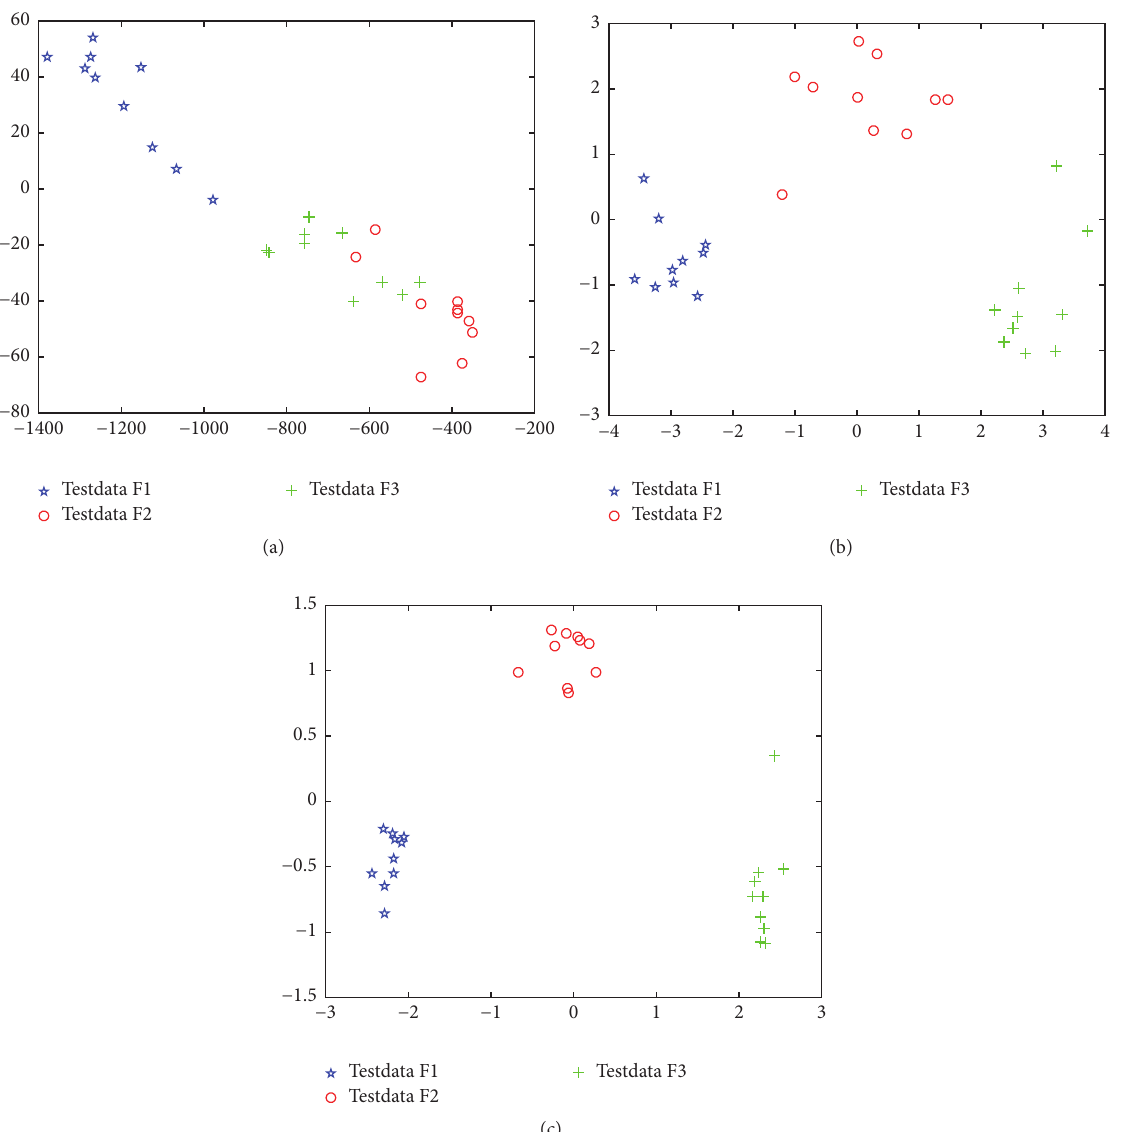
Figure 3: Feature extraction to Wine dataset: (a) PCA. (b) DSPCA. (c)